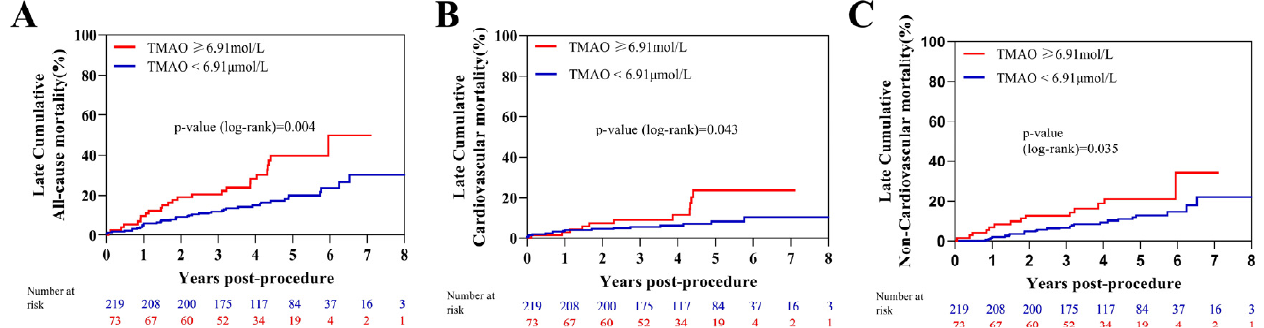
Table 3. Clinical outcome of patients after TAVR according to quartiles of TMAO (Q4 vs. Q1–3). Clinical outcome